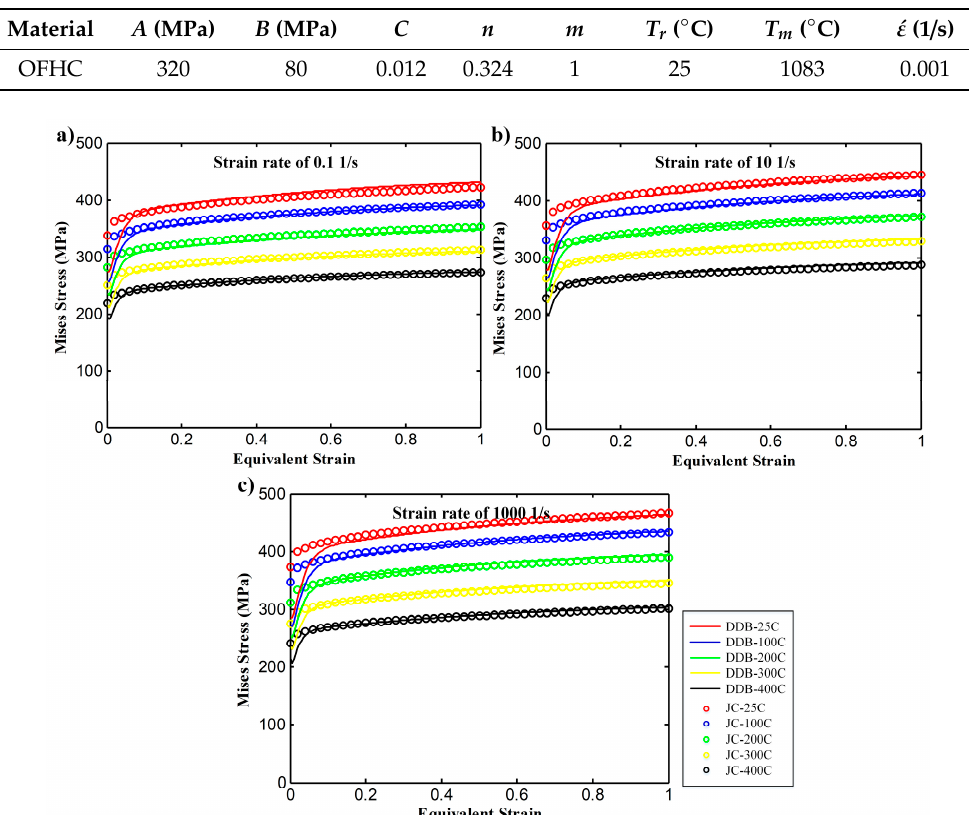
Table 3. Controlling parameters of the polynomial function for k 0.